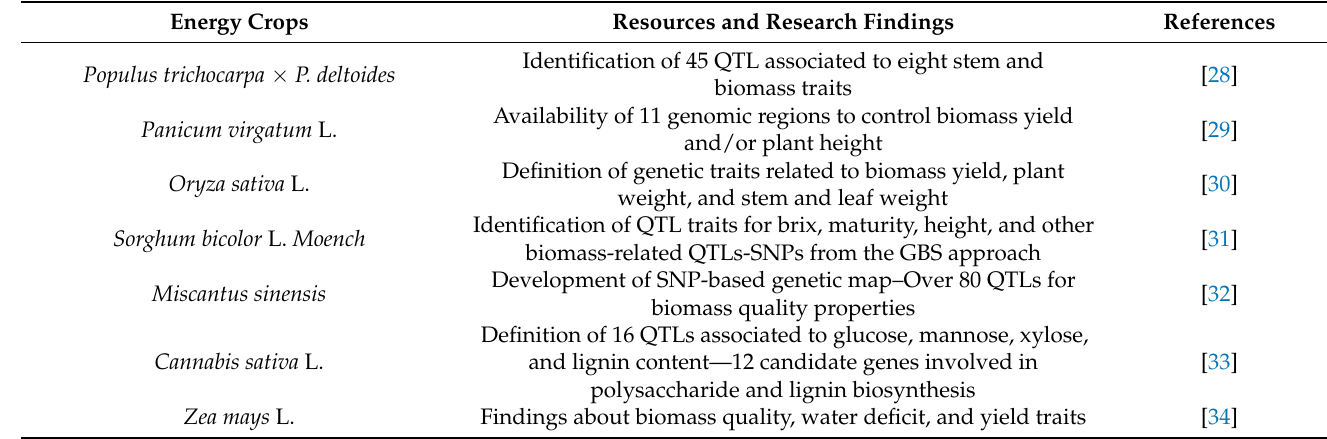
Table 3. Molecular markers and QTL mapping resources for energy